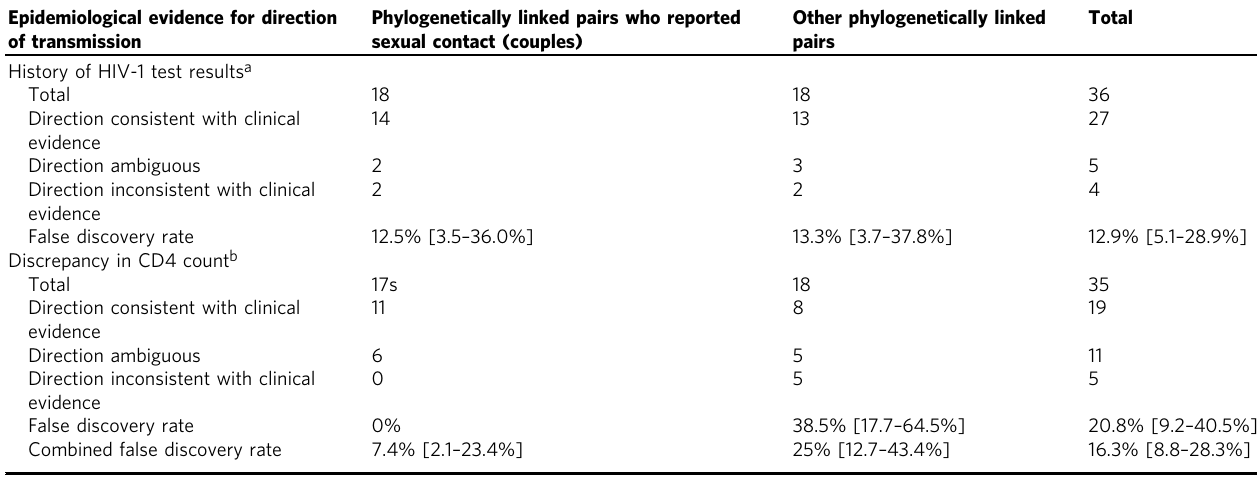
Table 2 Error rates in inferring the direction of HIV-1 transmission Epidemiological evidence for direction of transmission